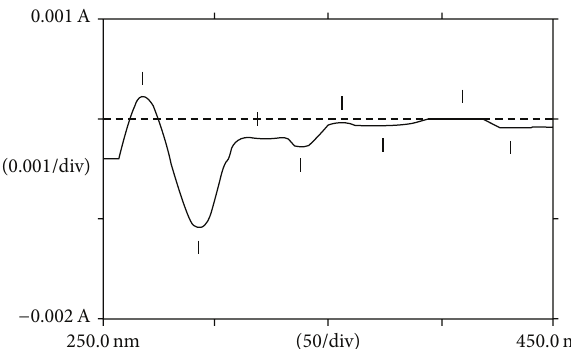
Figure 6: First derivative spectrum of colistin solution treated with 1M NaOH for 15 minutes.